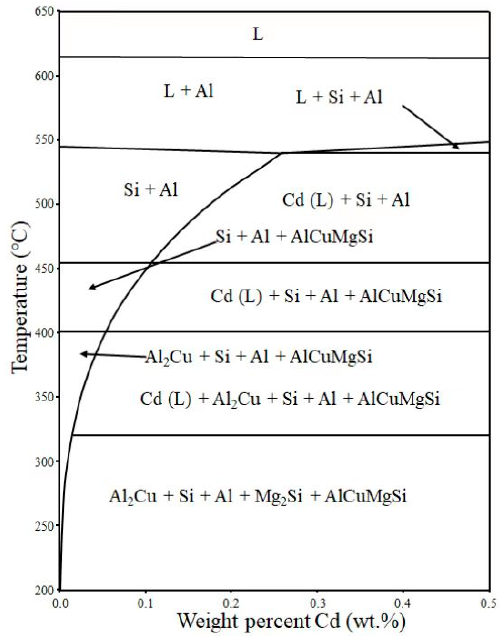
Figure 8. Calculated phase diagram showing the solubility of Cd in the Al-6.5Si-1.5Cu-0.25Mg ma- trix of the Al alloy as a function of temperature. In the phase diagram, L is liquid.